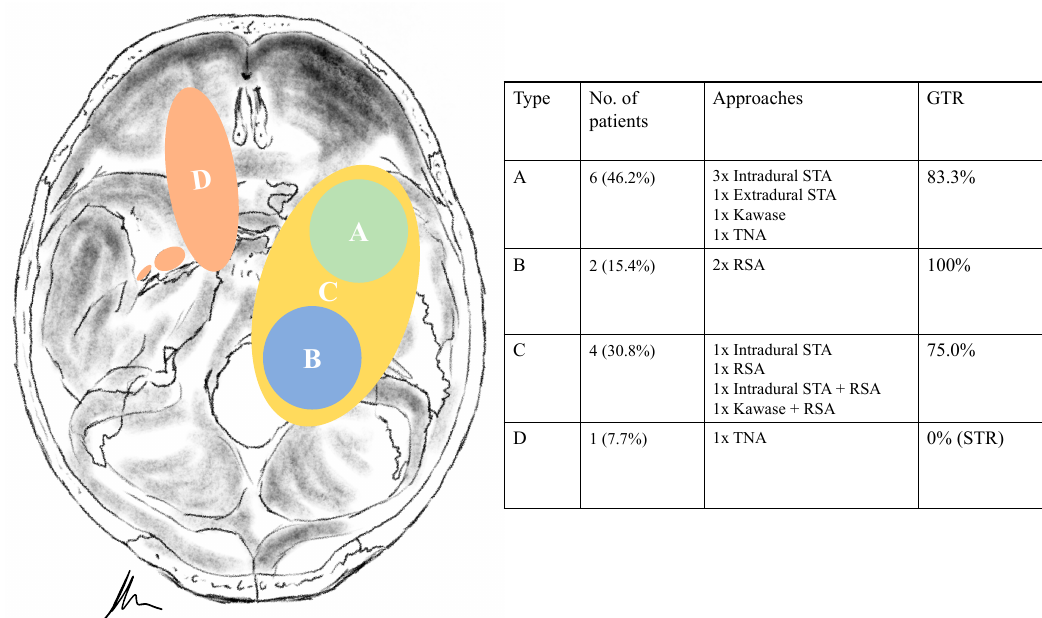
Figure 8. Illustration displaying surgical techniques and outcomes for each tumor type (according to Samii). STA = Sub- temporal approach. TNA = Transnasal endoscopic approach. RSA = Retrosigmoid approach. GTR = Gross total resection. STR = Subtotal resection.